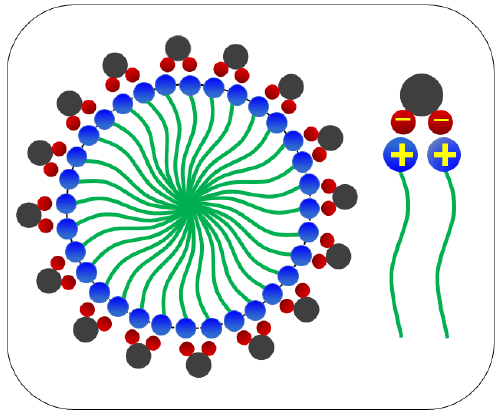
Figure 2. Modified Gemini-like Visco-Elastic Surfactant (VES).